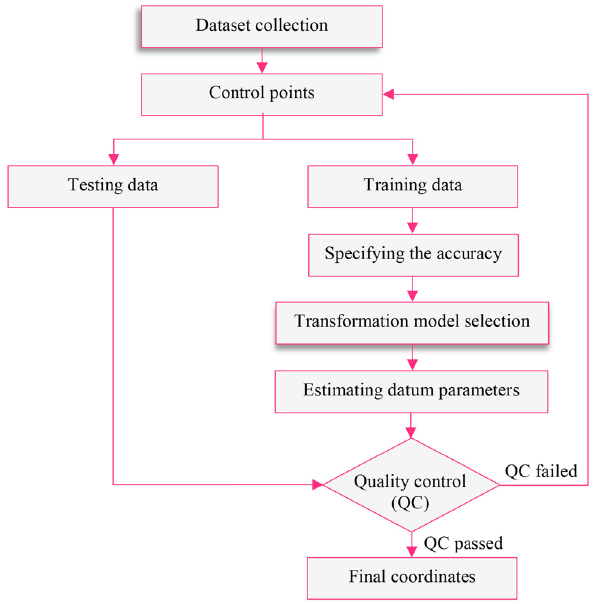
Figure 9: Depiction for developing datum transformation